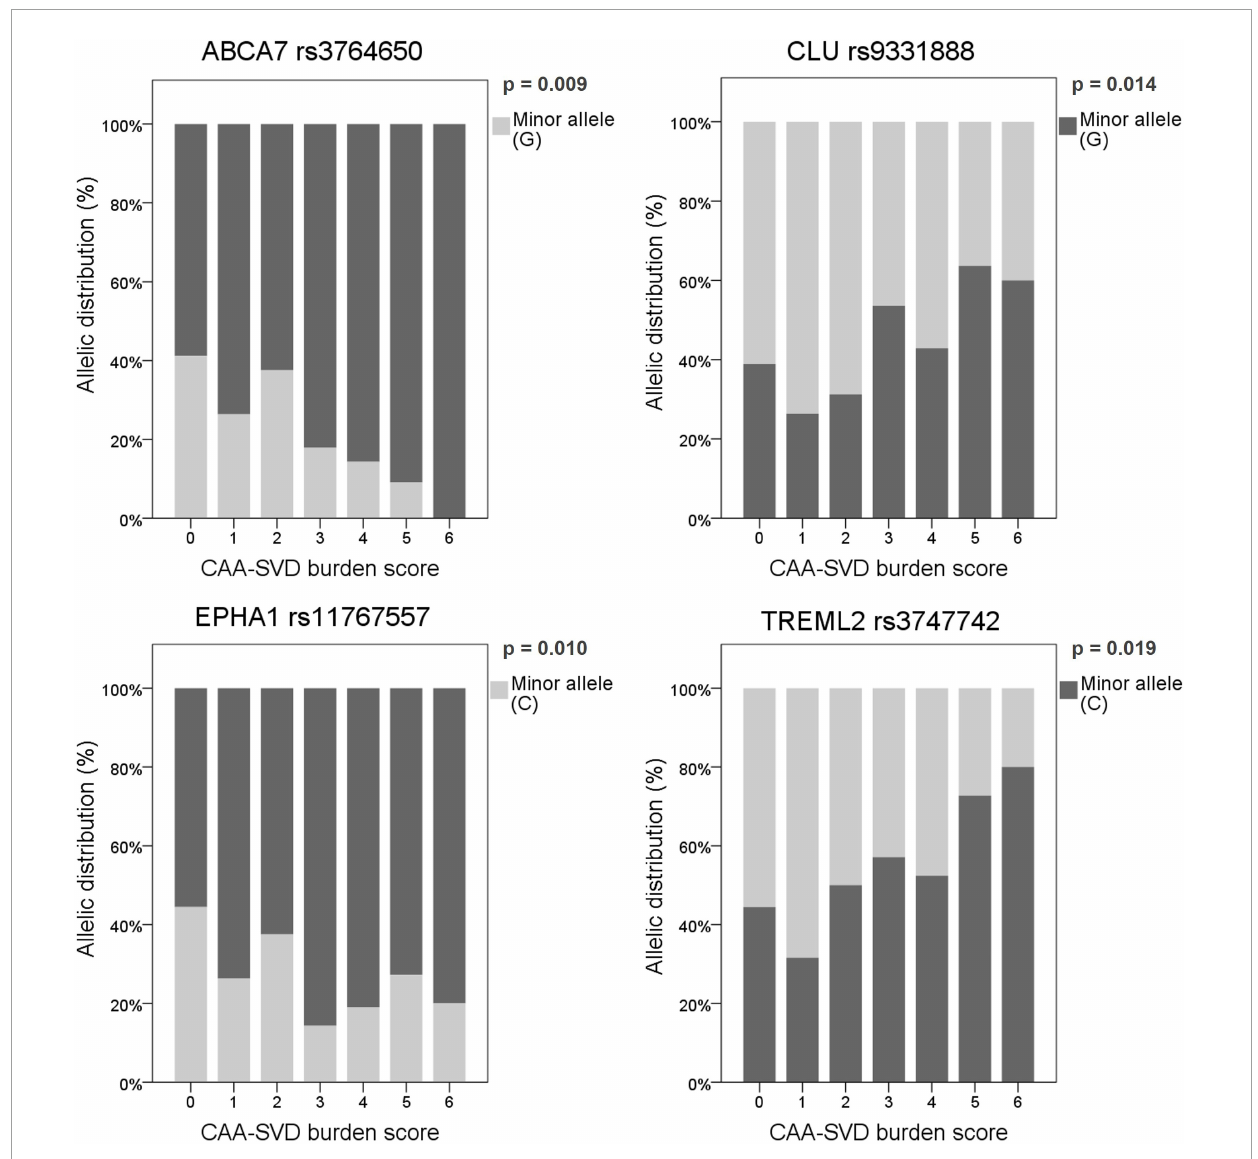
FIGURE1 Allelic distribution of the SNPs associated with the CAA-SVD burden score using the common dominant model. The genetic risk factor (presenting or not the minor allele) associated with a higher score is represented in dark gray, whereas the protective factor is represented in light gray. Allelic distribution is expressed as a percentage in each category of the score